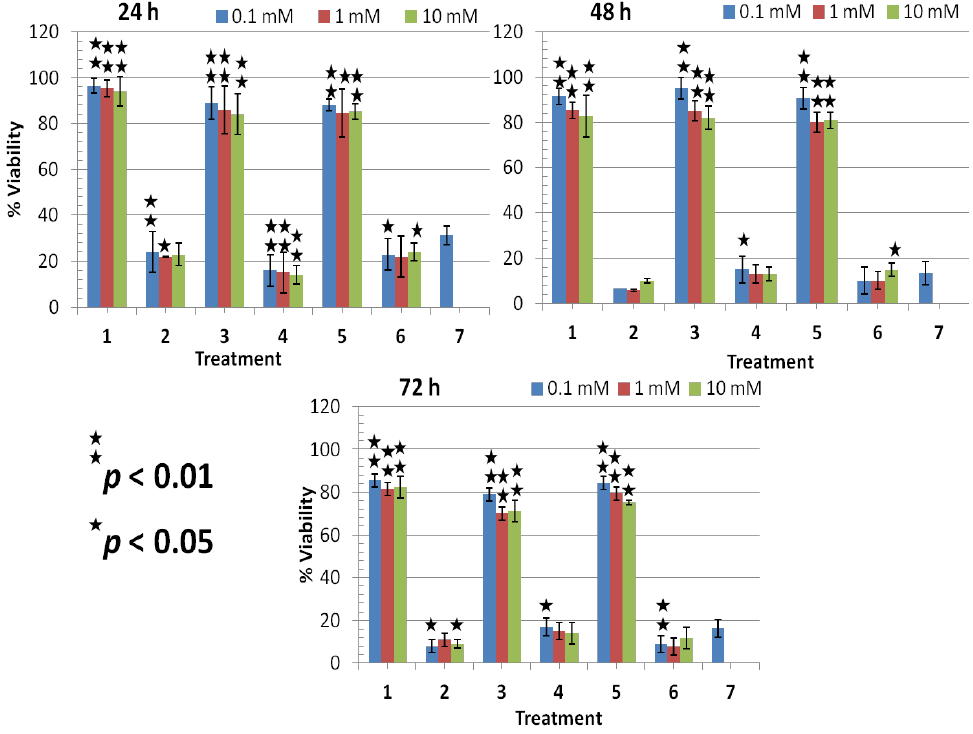
Figure 5. % Viability evaluated from MTT assay on treated T98G malignant cells at lower concentrations of osmolytes (0.1 mM, 1 mM and 10 mM) with or without plasma. Data presented are mean ± SD of at least three independent experiments (n = 3) and statistically